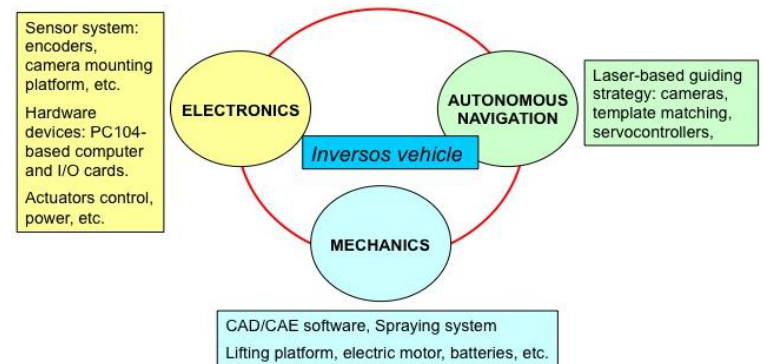
Figure 1. Mechatronic paradigm followed in this